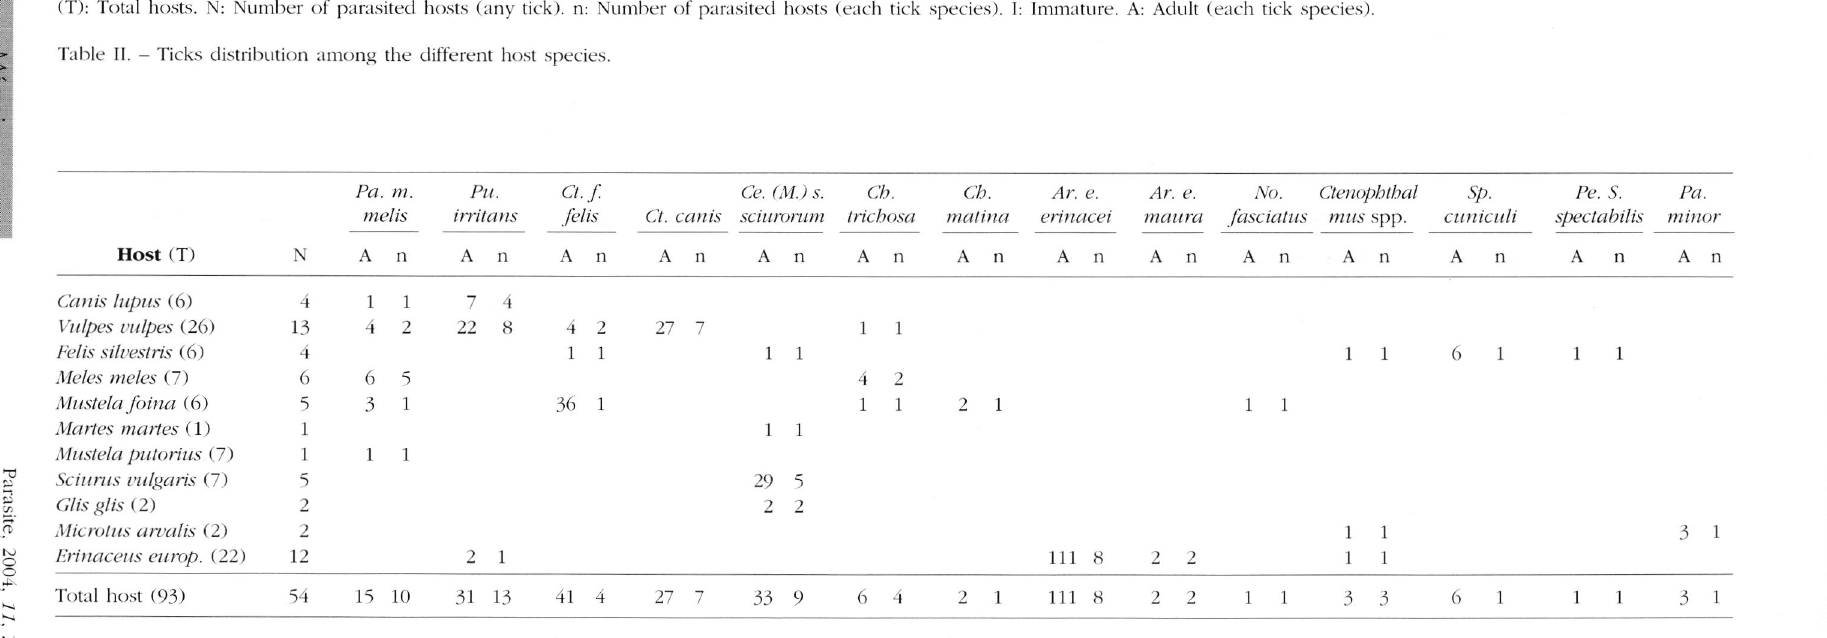
Table III. — Flea distribution among the different host